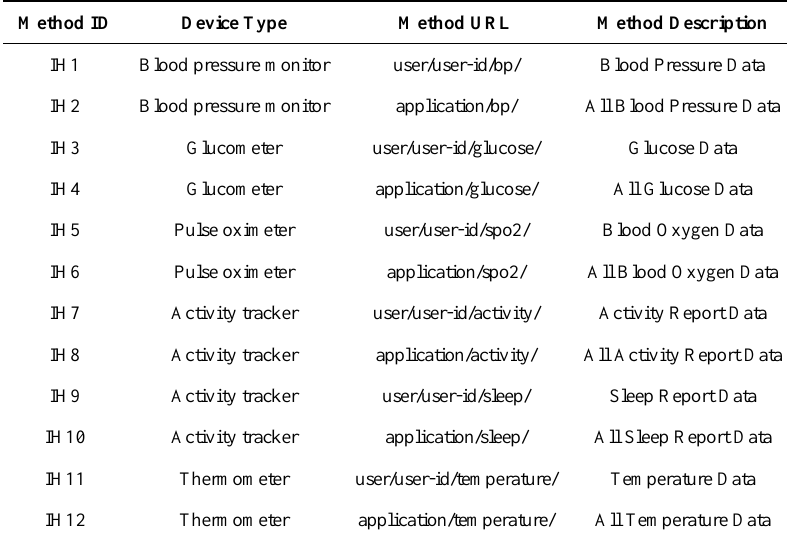
Table 3. API methods of iHealth